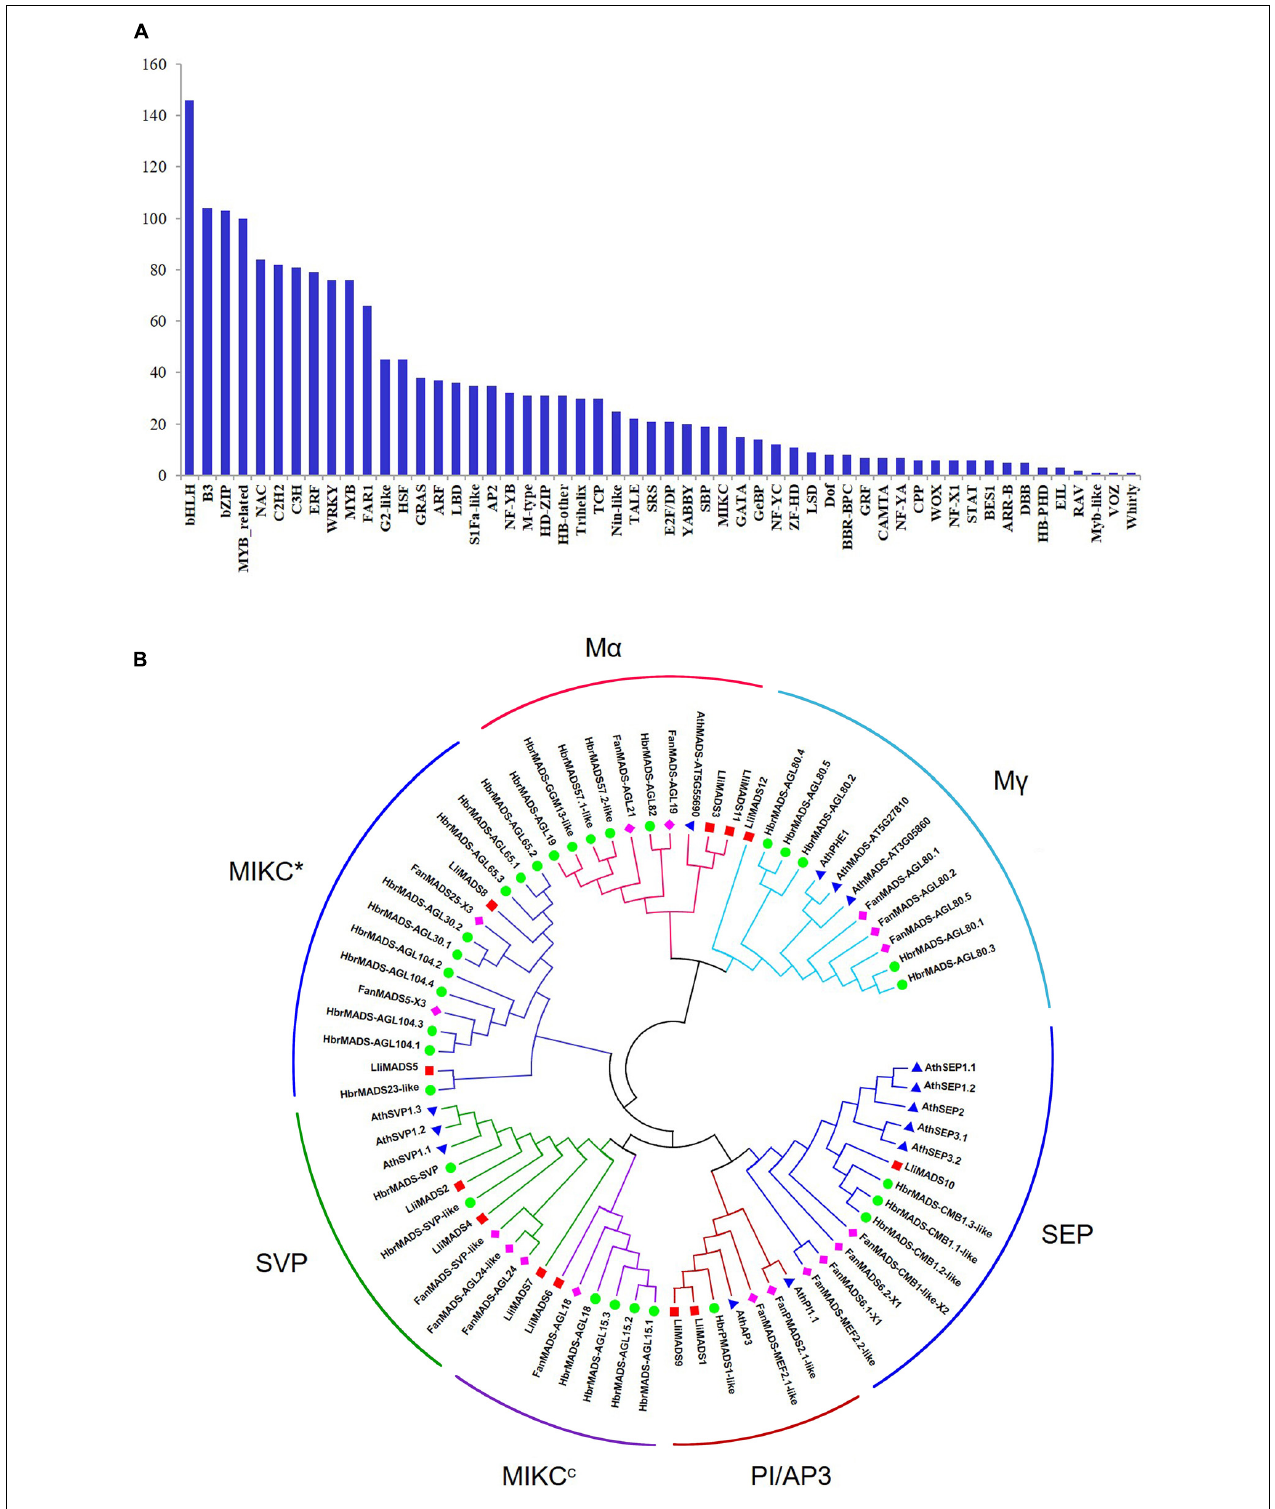
FIGURE 2 | Identification of TFs and MADS-box genes in DEGs of Lumnitzera littorea. (A) Classification of TF families. (B) Phylogenetic relationships of MADS-box TF CDSs from L. littorea , Arabidopsis , Fragaria ananassa , and Hevea brasiliensis . The unrooted phylogenetic tree was created with MEGA-X by the neighbor-joining method, and the bootstrap test was performed with 1,000 iterations. Red, blue, green, and purple dots indicate L. littorea , Arabidopsis , Hevea brasiliensis , and Fragaria ananassa genes, respectively. The outer circle shows the identified subfamily in MADS proteins.